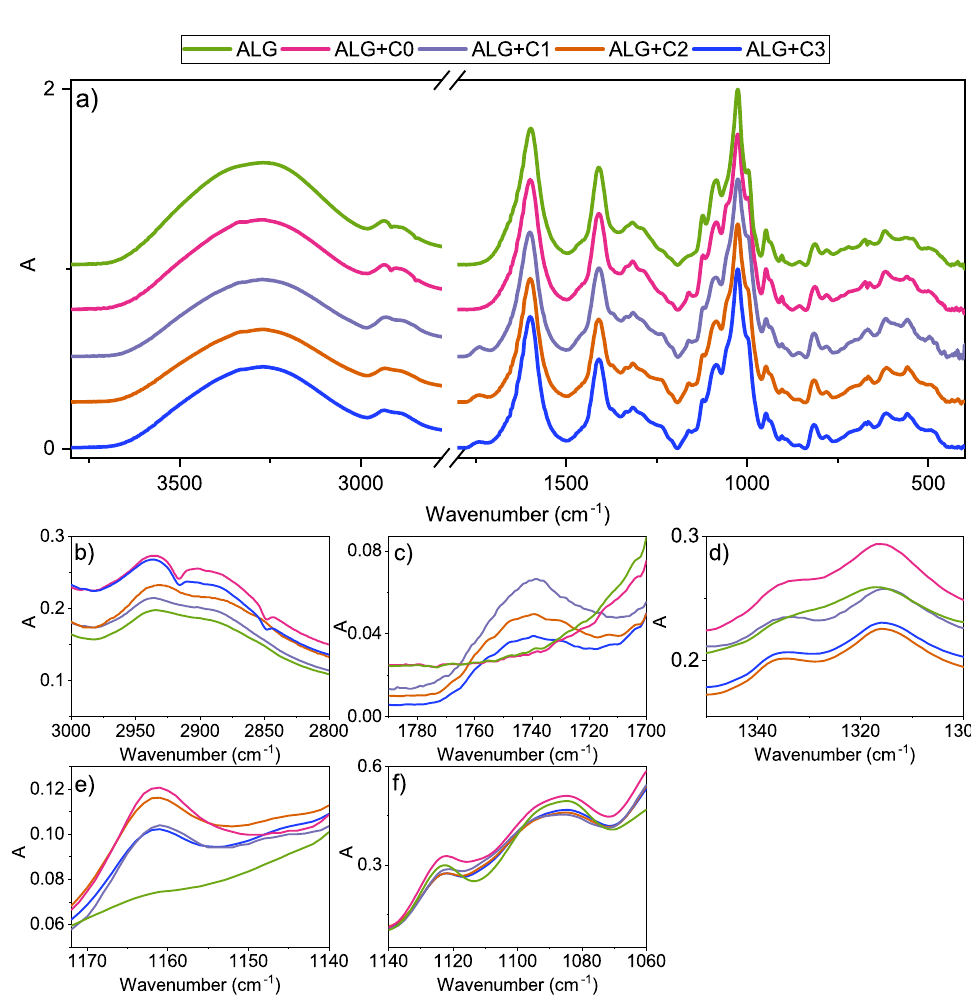
Figure 5. ( a ) FTIR–ATR analysis of alginate-based films with and without integrated CNCs of various DS, with subfigures ( b – f ) exhibiting regions where change upon addition of pristine or modified CNCs is